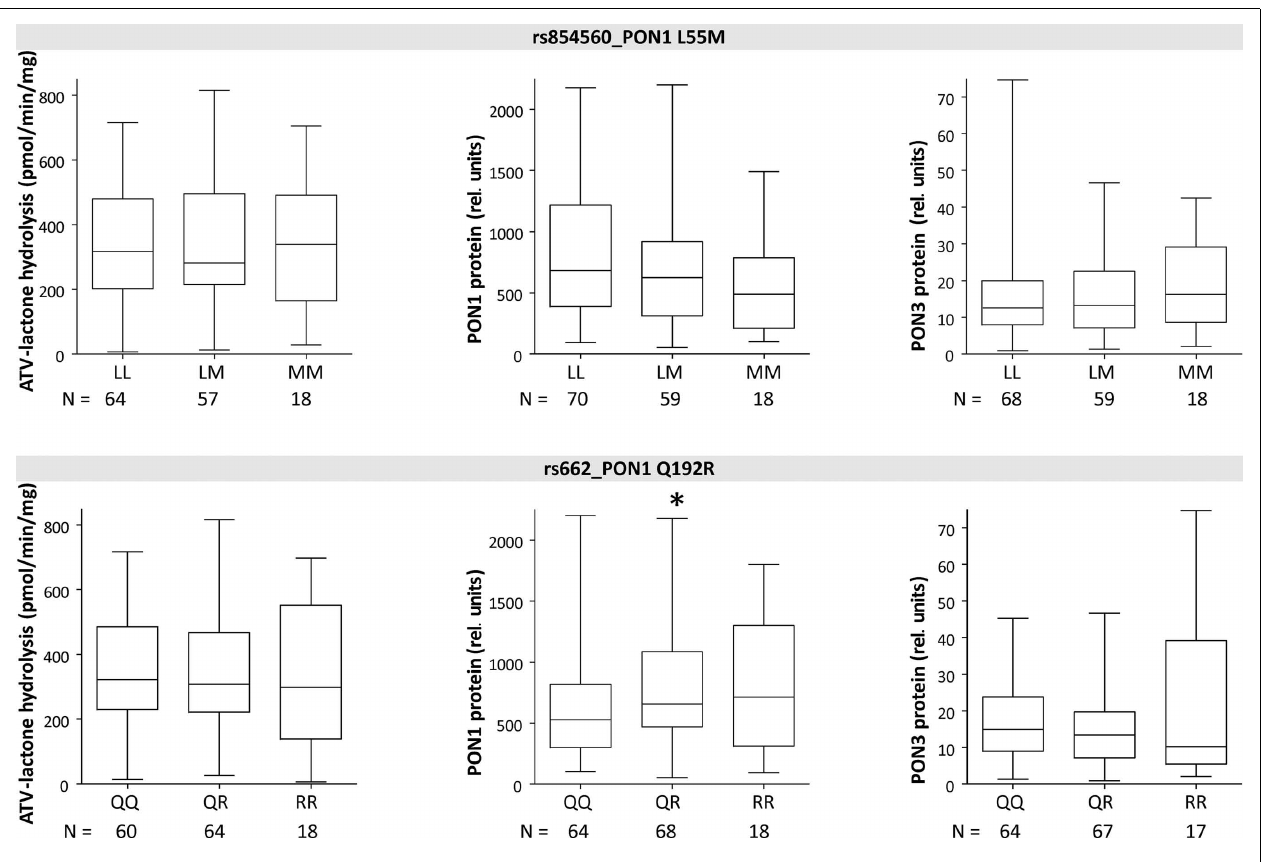
are compared with homozygotes of reference allele byWilcoxon–Mann– Whitney-tests significance levels are indicated for P < 0.05 (*), P < 0.01 (**), and P < 0.001